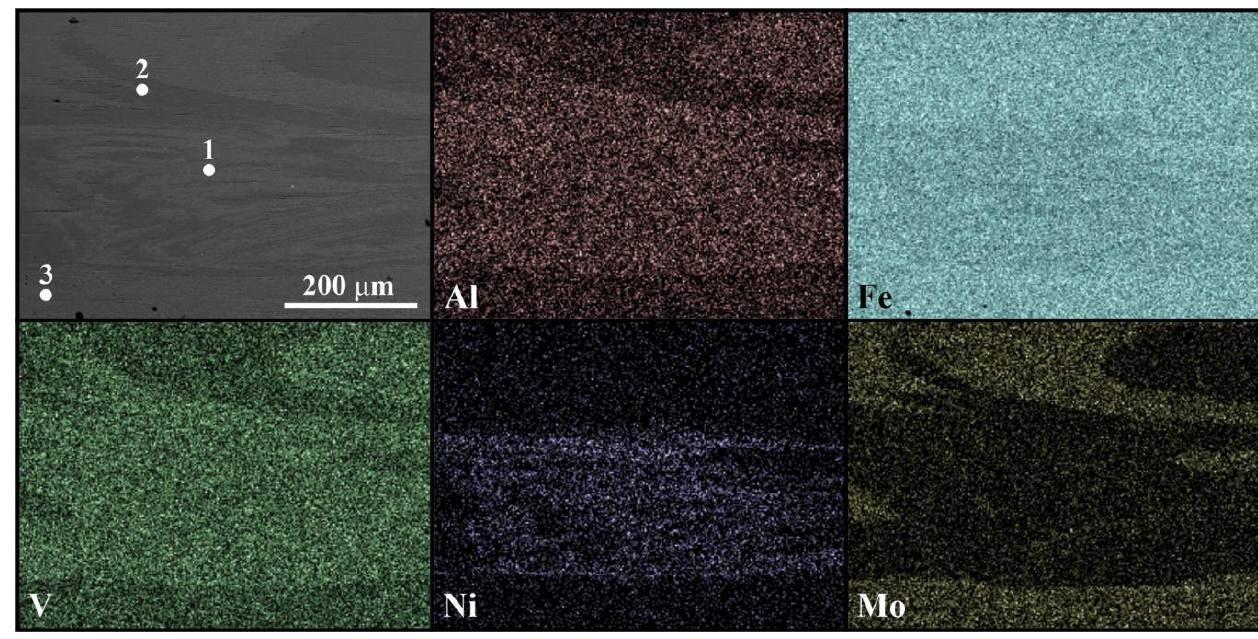
Figure 21. SEM image of the joint section and EDX maps of the tool and titanium alloy elements in the Ti-4Al-3Mo-1V and Ti-6Al-4V joint. Table 9. Results of the chemical composition analysis performed on the section of the joint.